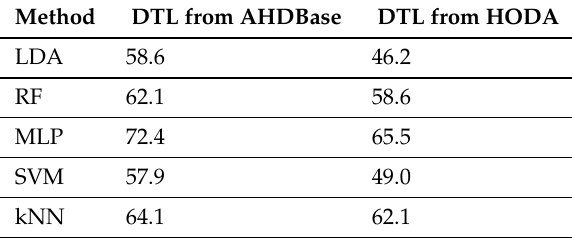
Table 4. Results obtained by applying different classifiers to extracted features by using deep transfer learning. DTL from AHDBase and HODA datasets are shown in separate columns.